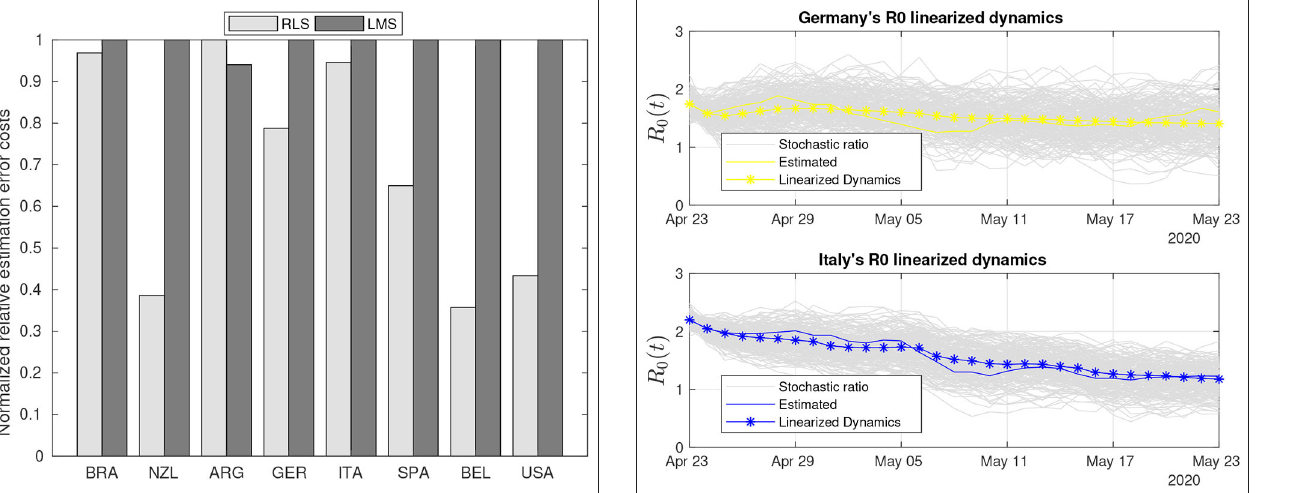
FIGURE 8 | Thirty days of linearized R 0 dynamics for Germany and Italy. Both countries display low variability in the stochastic ratio curve.